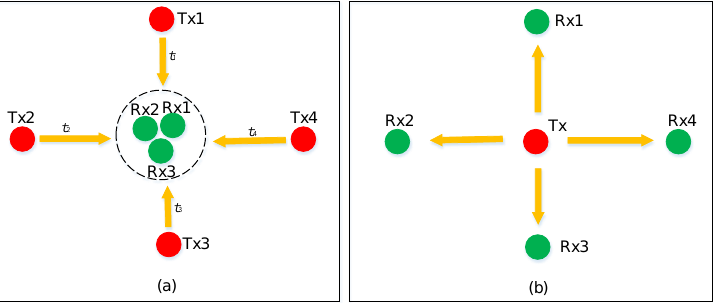
Figure 2. The two work modes for the ultrasonic signal: ( a ) and ( b ), Tx: transmitter, Rx: